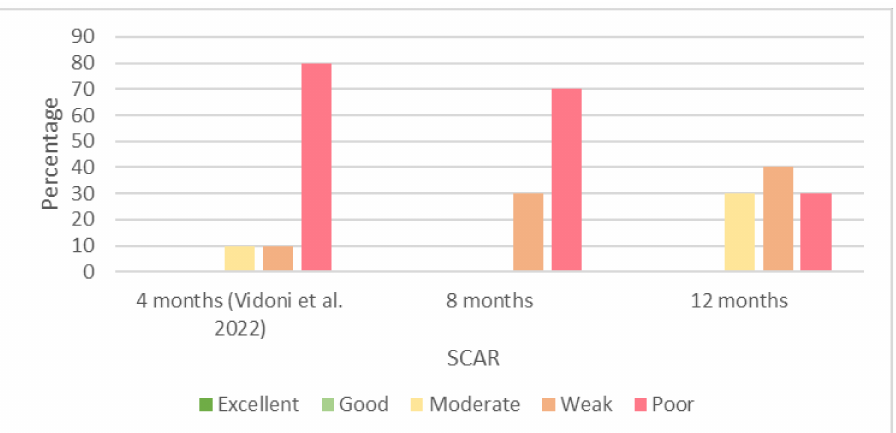
Figure 2. Percentages of results of interobserver agreements (Cohen’s kappa coefficient) for sclerosis of cranial acetabular rim (SCAR) at 4 [29], 8, and 12 months of